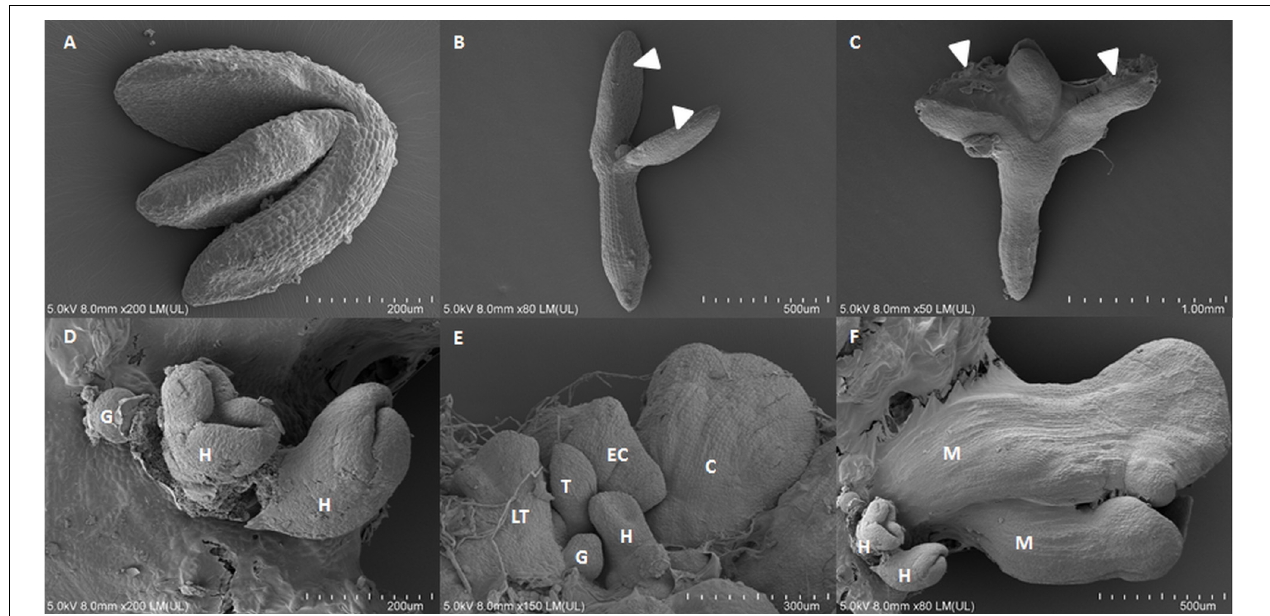
FIGURE 1 | Scanning electron microscopy images of the somatic embryogenesis culture of Arabidopsis from immature zygotic embryos on a medium with 5 µ M of 2,4-D on 0th day (A) , 5th day (B) , 10th day (C) , and 15th day (D–F) of the culture. (D–F) Somatic embryos in the globular (G), heart (H), torpedo (T), late torpedo (LT), early cotyledonary (EC), cotyledonary (C), mature stages of development (M), arrow heads indicate tissue that is undergoing